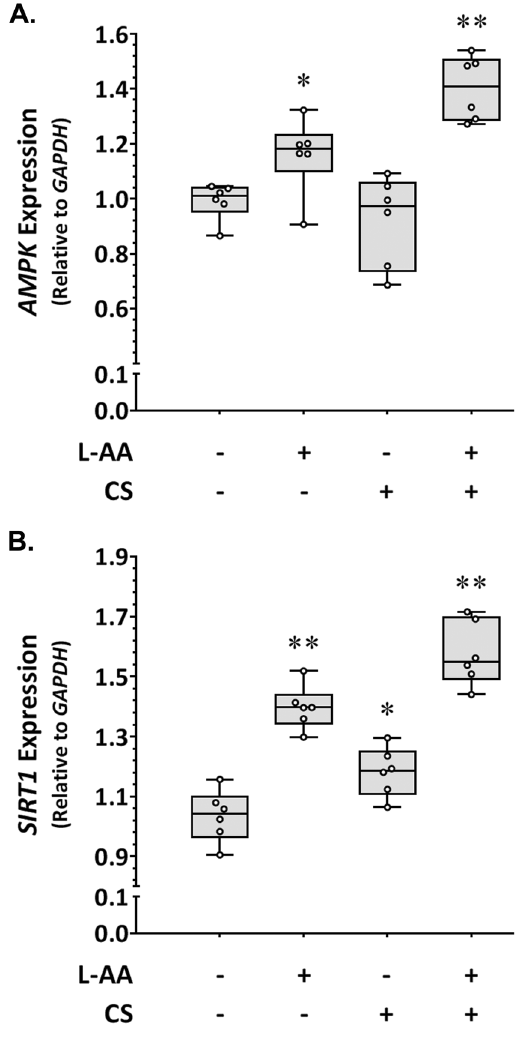
Figure 3. Effect of L-ascorbic acid and chondroitin sulphate on AMPK and SIRT1 expression in inflammation- activated VSMC in vitro . Upregulation of AMPK ( A ) ( * P = 0.041, ** P = 0.002) and SIRT1 ( B ) ( * P = 0.015, ** P = 0.002) in VSMCs incubated with L-ascorbic acid (L-AA) and chondroitin sulphate (CS) compared to control. Data expressed as median and interquartile range with maximum and minimum data points (whiskers) for relative expression and compared by Mann-Whitney U